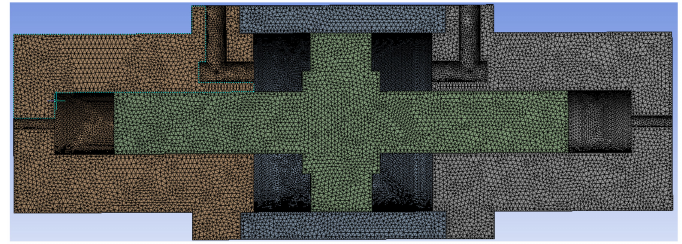
Figure 9. The piston is at the mid end.